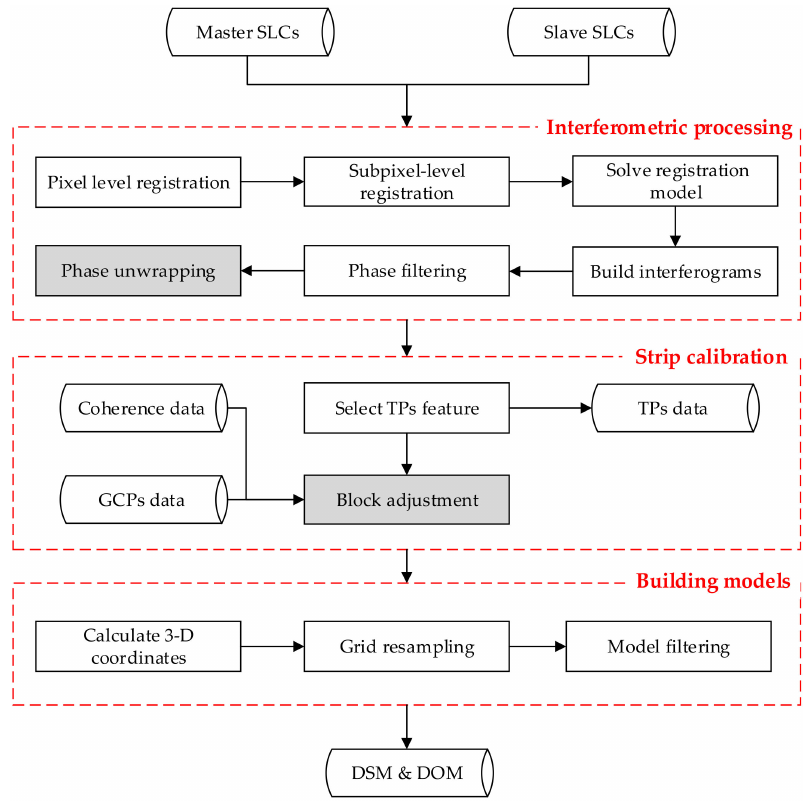
Figure 4. Processing flow chart of a DOM and DSM from airborne